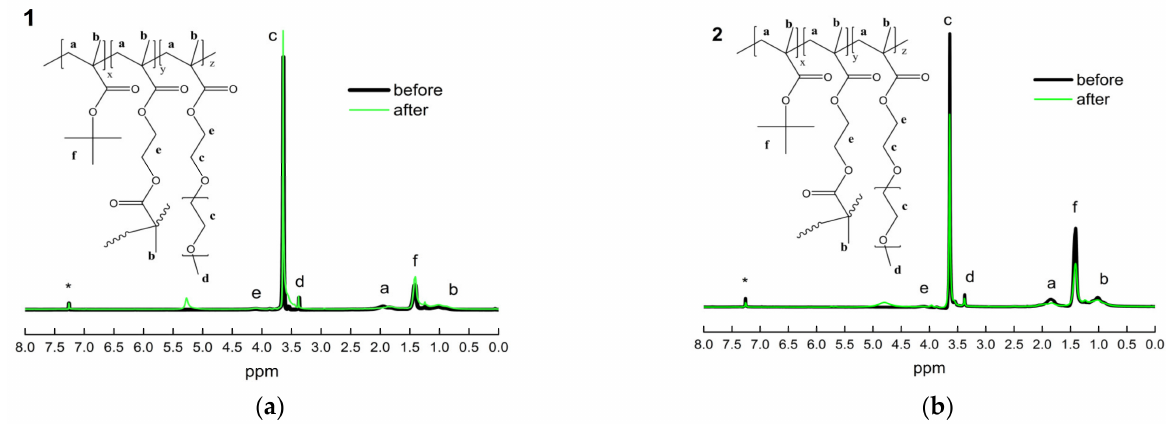
Figure 2. 1 H-NMR spectra of the HC 1 ( a ) and HC 2 ( b ) in CDCl 3 before and after